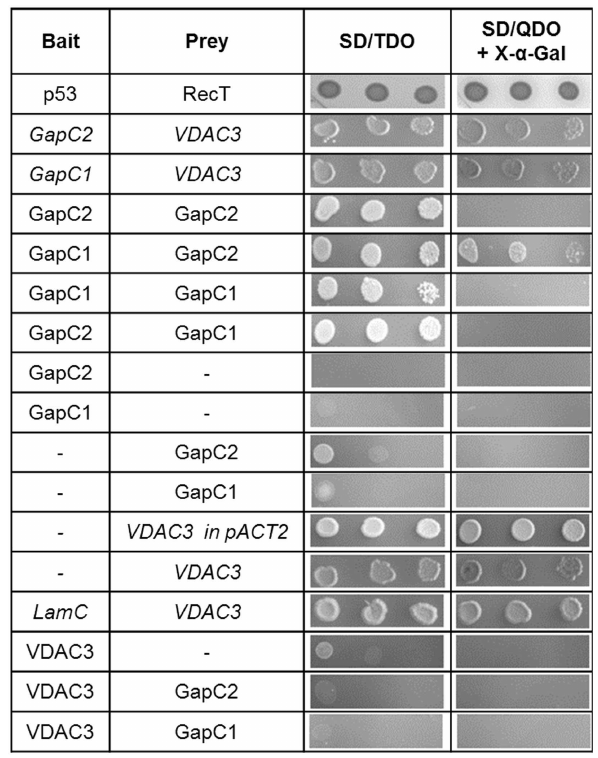
FIGURE 3 |Yeast 2-hybrid “one-on-one” assays between GapC isoforms, aldolase, andVDAC3. Putatively positive interactions had been identified in the yeast two-hybrid screen of the cDNA library from A. thaliana . Here, to retest these findings, the haploid yeast strain AH109 was cotransformed with constructs, expressing bait, or prey proteins, as indicated in the table. Serial dilution of the appropriate overnight yeast culture was dropped onto selective media to demonstrate the stringency of binding between proteins. Colonies growing on SD/Leu − ,Trp − were successfully transformed with both vectors, encoding the investigated proteins. Growth on SD/TDO and SD/QDO/X- α -Gal is a sign of positive interactions. Italics indicate false positive results due to autoactivation by VDAC3 when used as a